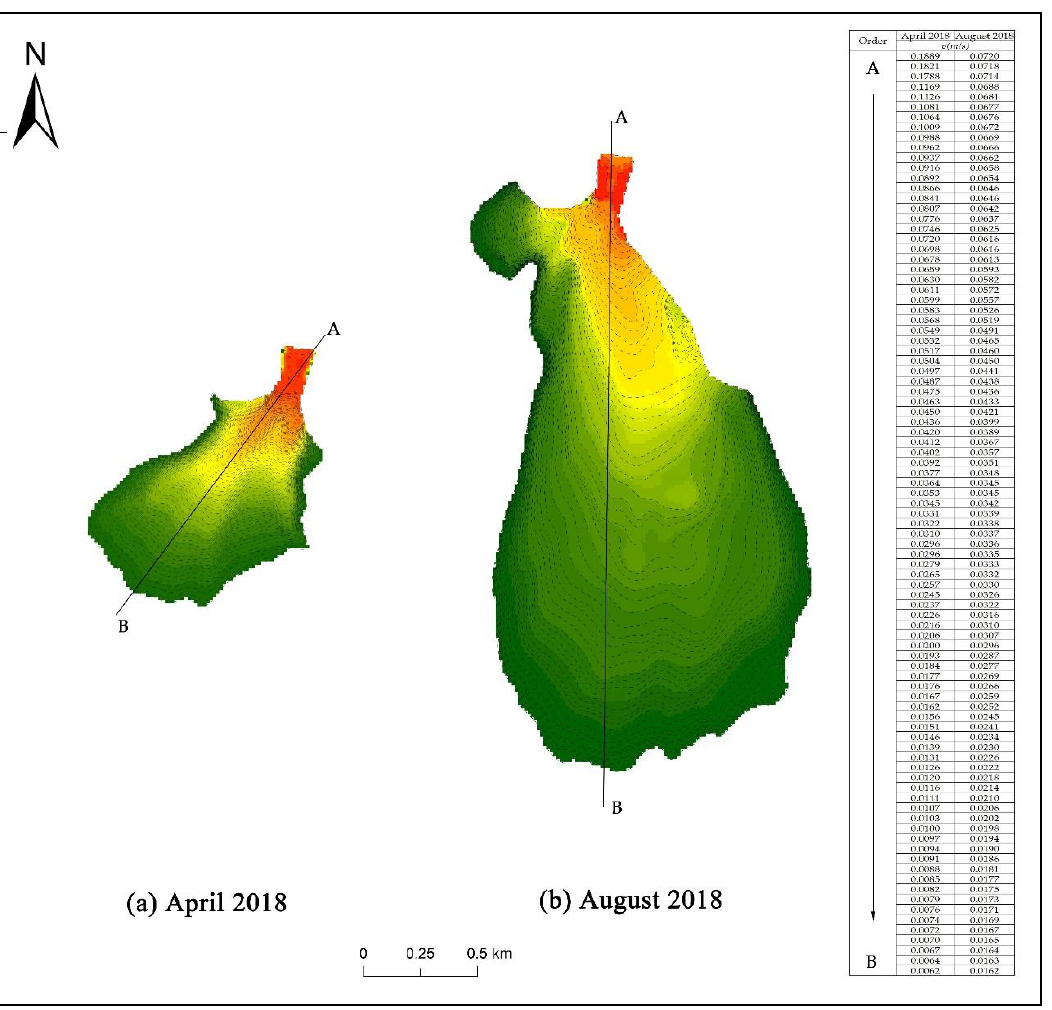
Figure 12. Distribution of flow velocity in the Baigou Canal–Baiyangdian Lake transition zone. ( a ) April 2018, when the range of the transition zone was smallest, ( b ) August 2018, when the range was largest. Charts for the flow fields in other months are shown in Appendix B Figure A2. Table 3. Calculation of the flow velocity gradients G ij and G ki in the Baigou Canal–Baiyangdian Lake transition zone. Figure 5 shows the positions of lines k , i , and j .